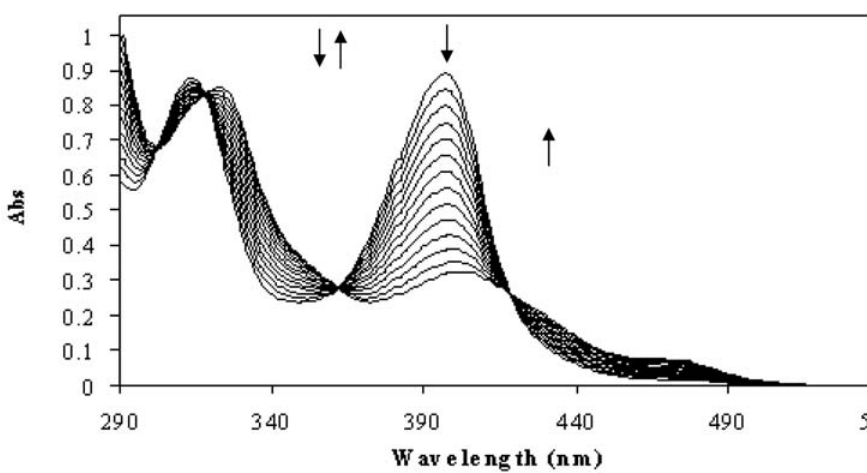
Figure 1. The variation of the electronic spectra of (H